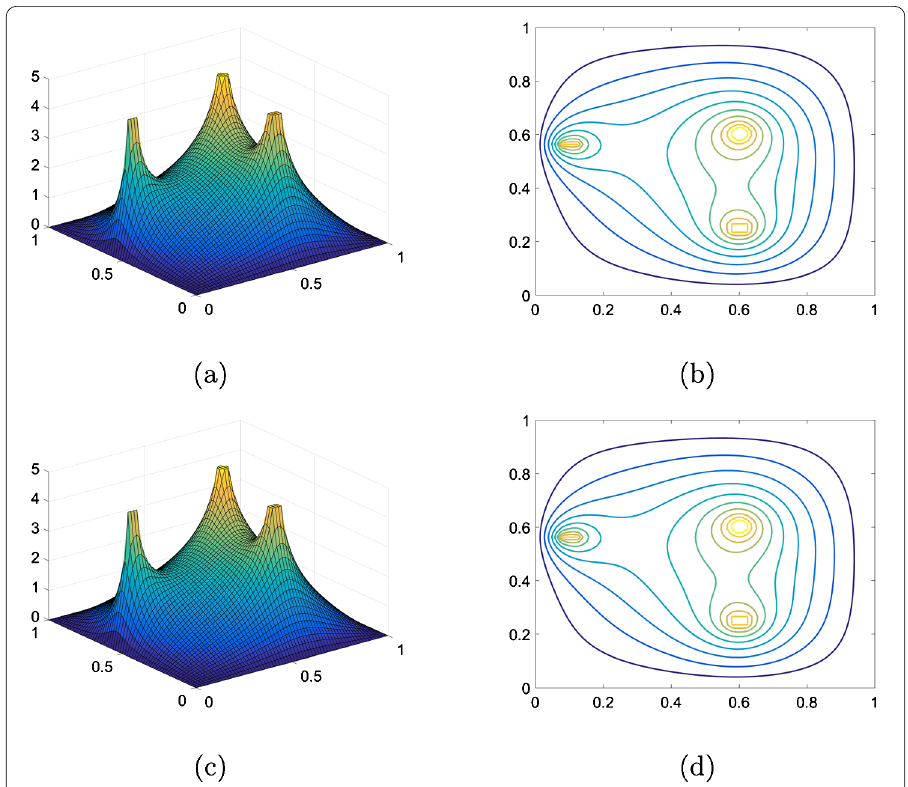
Figure 3 Solutions to the linear problem for the obstacle ϕ 1 (5.3) at resolution 64 × 64. (a) The numerical solution by the PDL1P, (b) its contour plot, (c) the numerical solution by the obstacle SOR, and (d) its contour